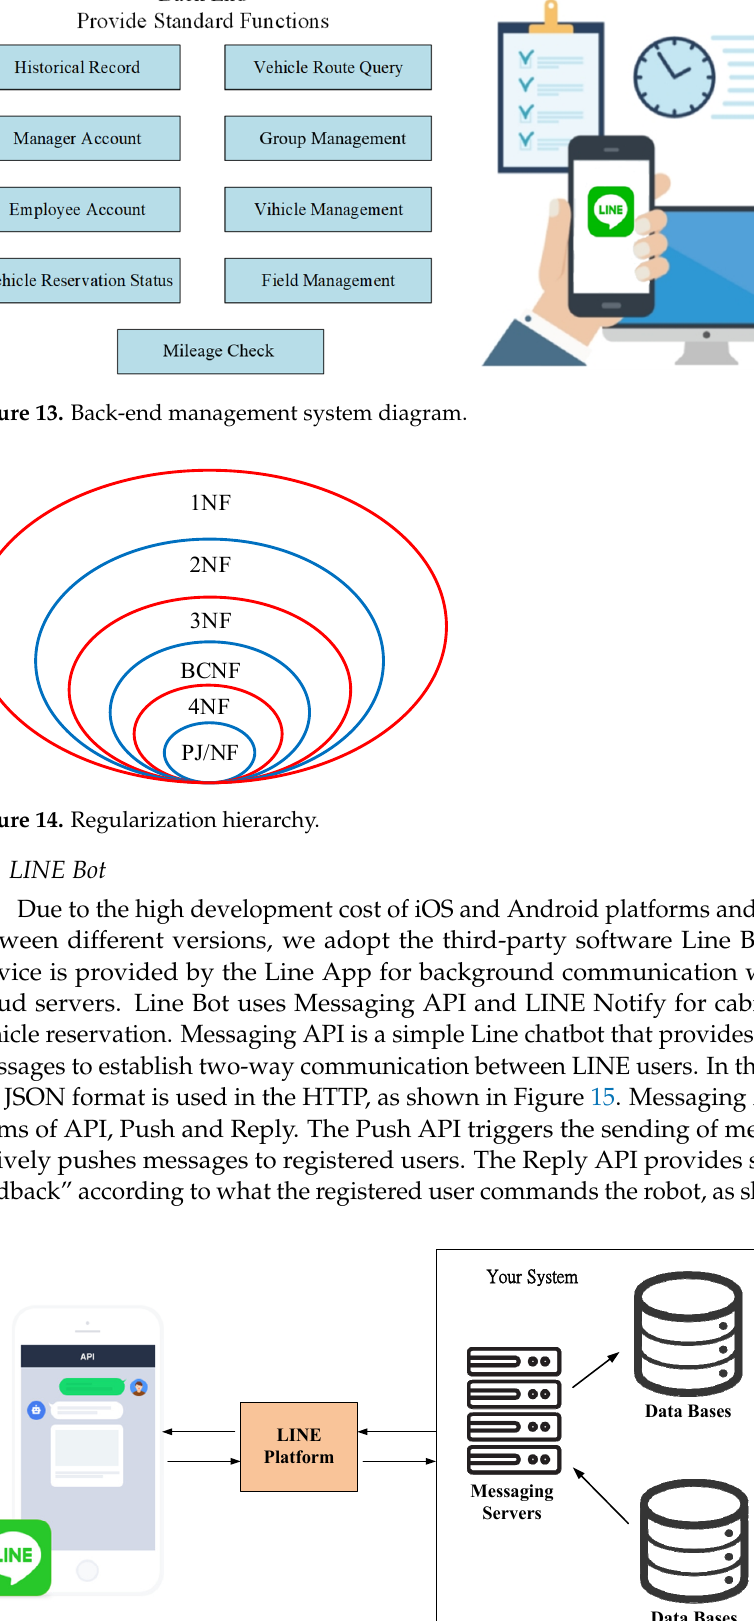
Figure 13. Back-end management system diagram.